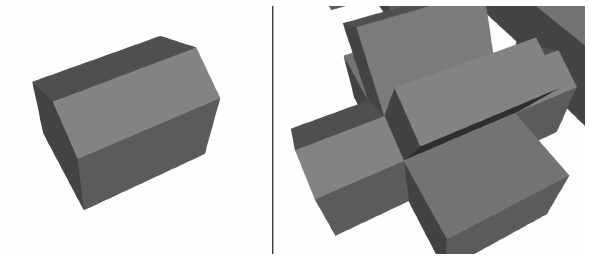
Figure 2. Example of extruded volumes for ROI selection for a single